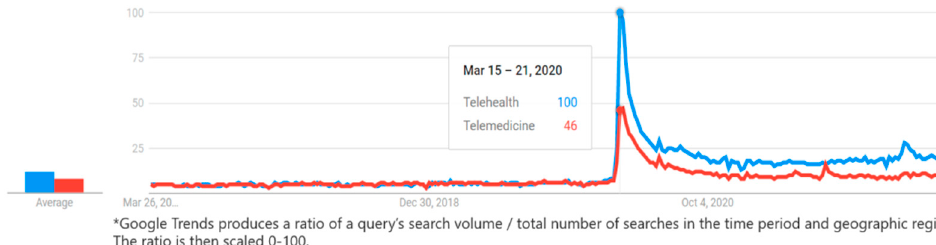
Figure 1. Google Trends search for “Telehealth” and “Telemedicine”